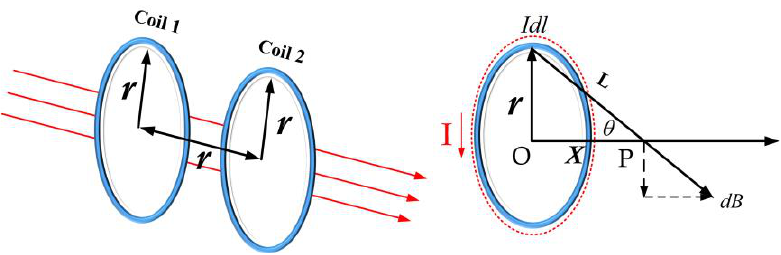
Figure 7. Schematic diagram of the geometric relationship of the Biot-Savart law.